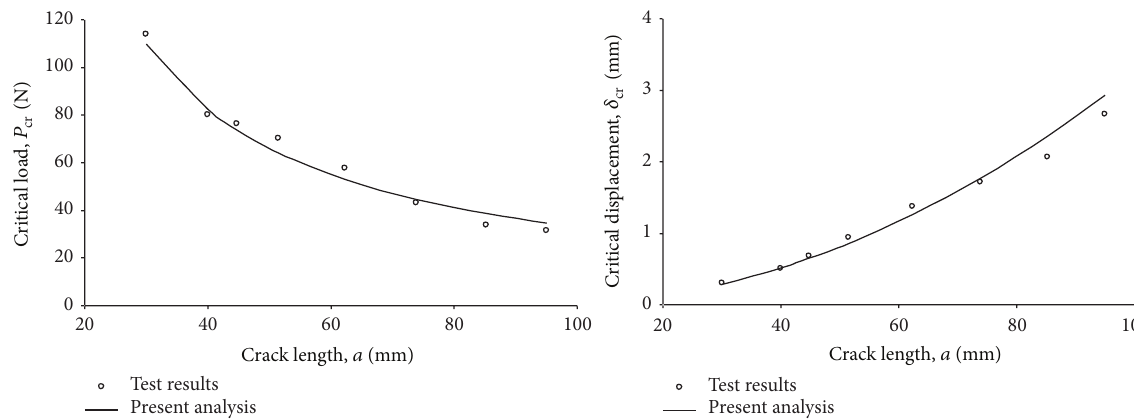
) and the corresponding displacement (𝛿 ) cr cr